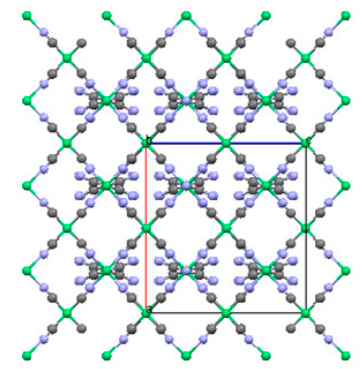
Figure 15. Ni-BPyNH2 square net view down the b -axis of the molecule (C-grey, N-blue, Figure. 15.